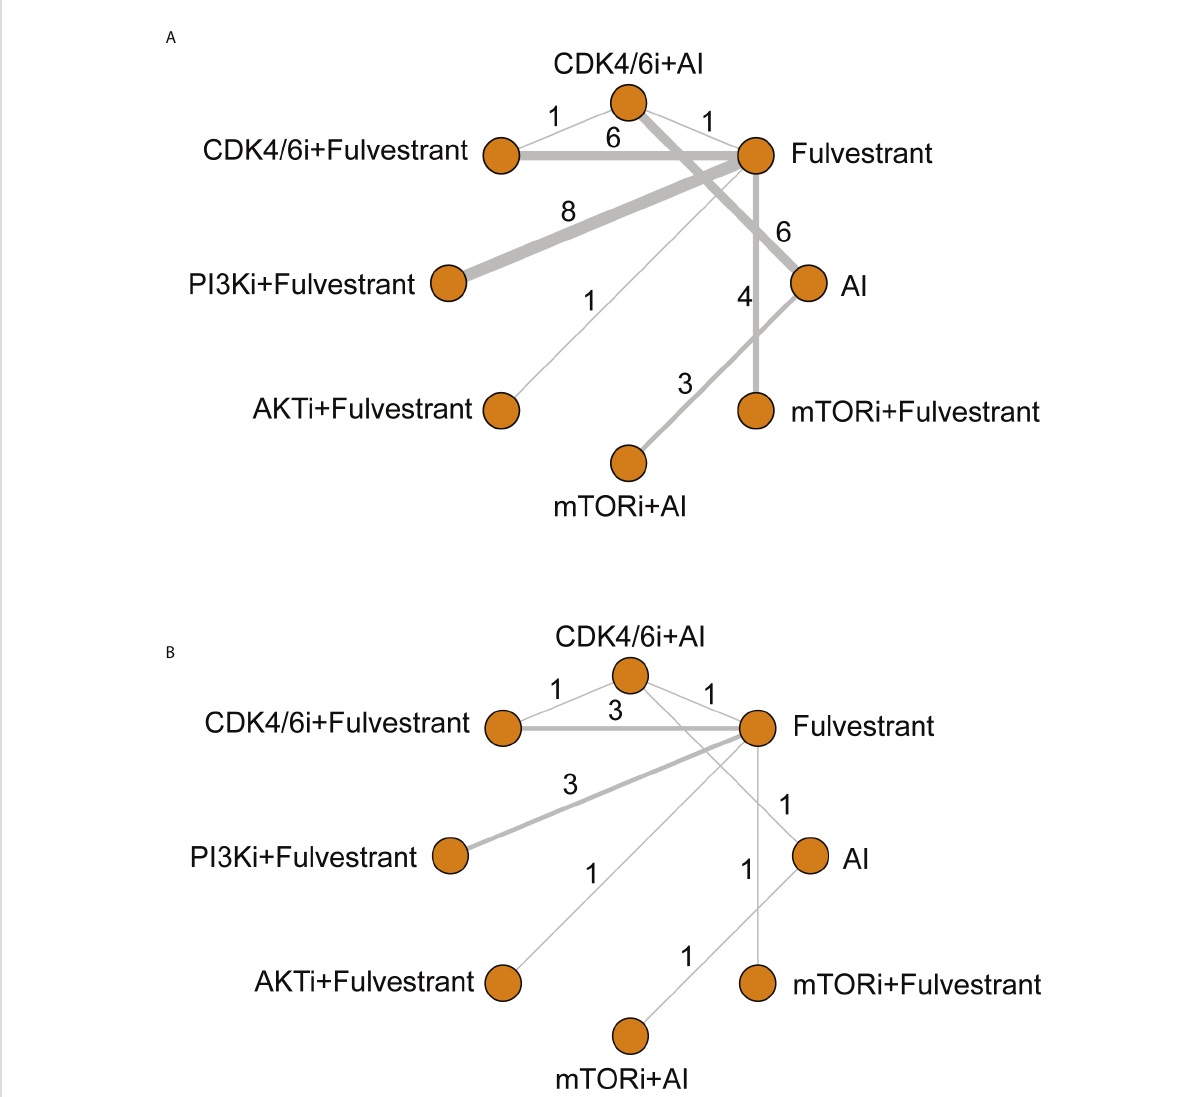
FIGURE 3 Network of comparative interventions for (A) PFS and (B) OS. CDK4/6i, CDK4/6 inhibitors; PI3K, PI3K inhibitors; AKTi, AKT inhibitors; mTORi, mTOR inhibitors; AI, aromatase